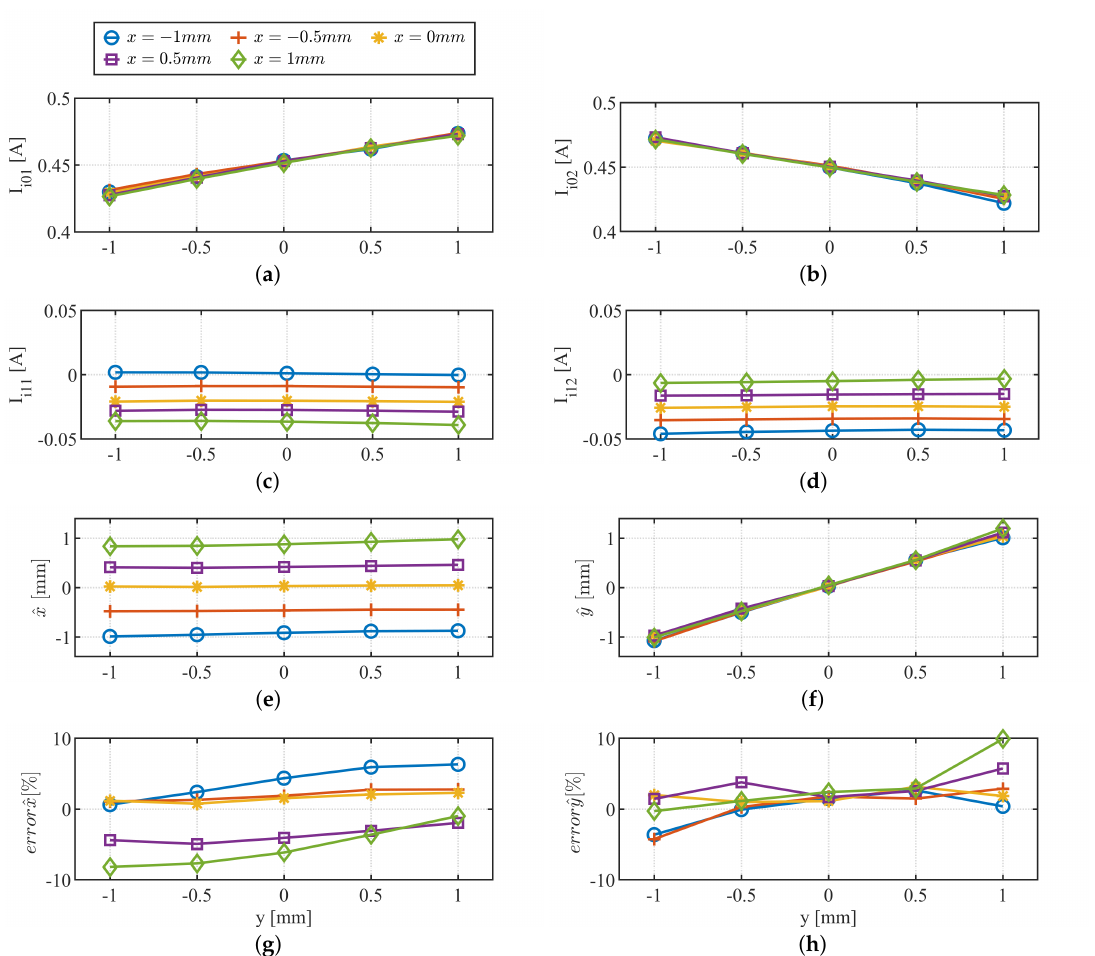
Figure 15. Experimental results varying y from +1 mm to − 1 mm in steps of 0.5 mm at constant x position. ( a ) I i 01 ; ( b ) I i 02 ; ( c ) I i 11 ; ( d ) I i 12 ; ( e ) ˆ x ; ( f ) ˆ y ; ( g ) error ˆ x ; ( h ) error ˆ y